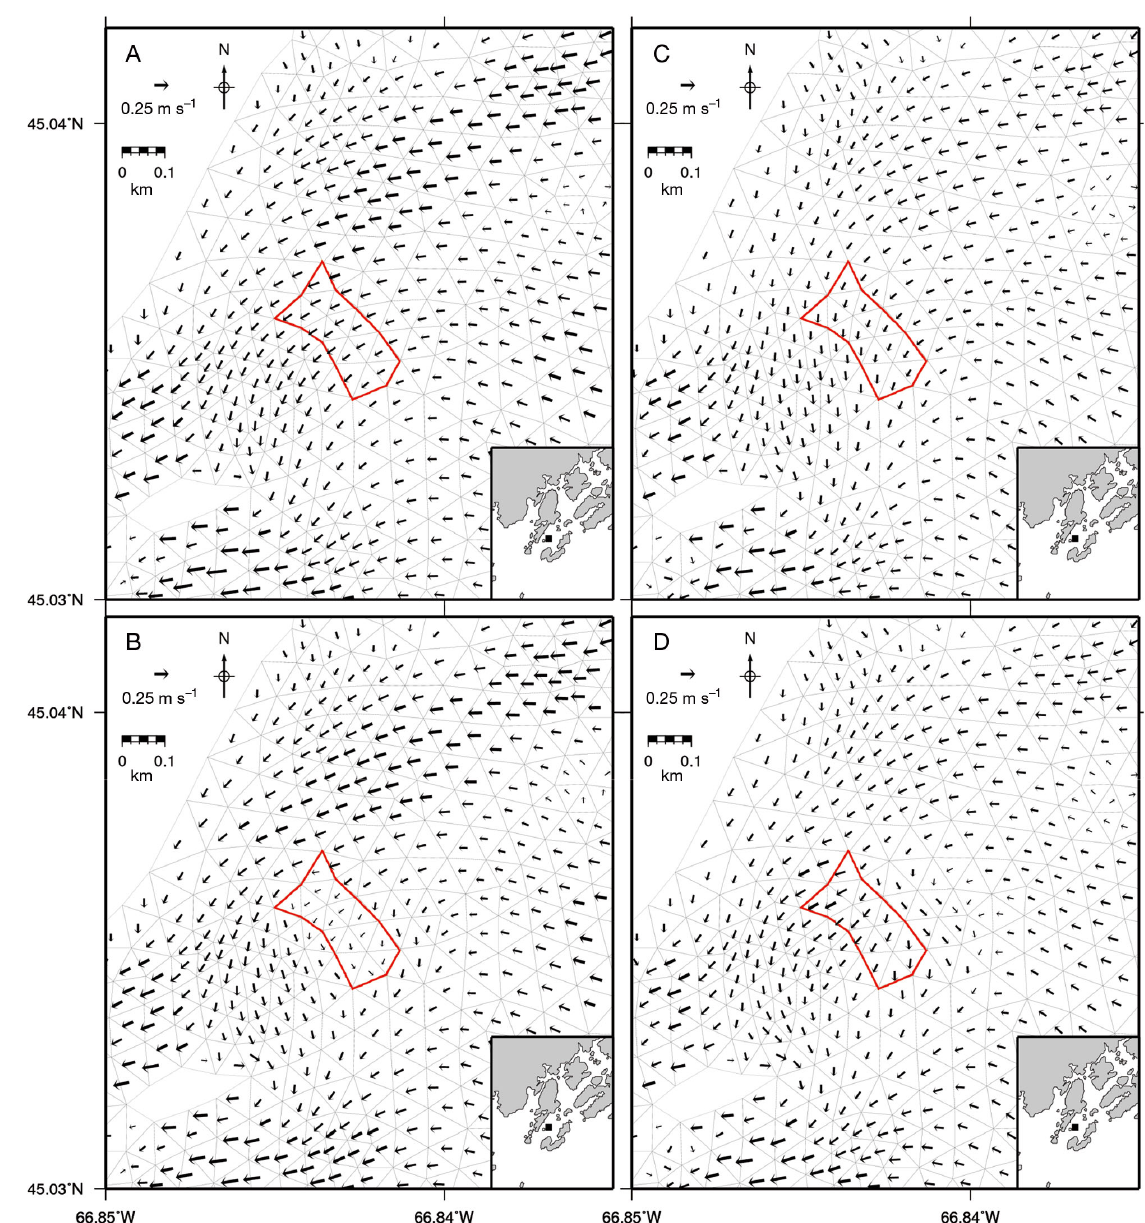
Fig. 6. Modelled current velocity fields at mid ebb tide (A,C) without and (B,D) with cage effect around Bliss Harbour fish farm (red outline, Fig. 1C). (A,B) Results for the surface layer (12 m above the seabed); (C,D) results for the bottom layer (1 m above the